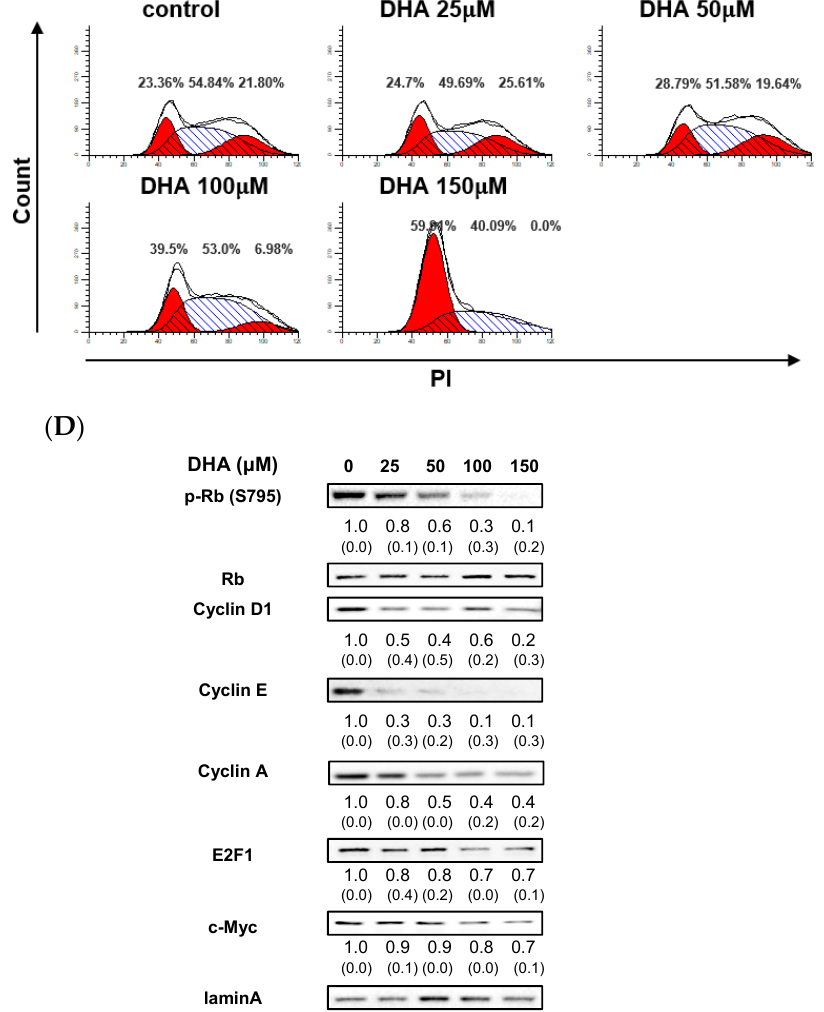
Figure 1. DHA inhibited the proliferation of human PDAC HPAF-II cells in association with down- regulation of cyclin D1 and c-Myc proteins. ( A ) Human PDAC HPAF-II, CFPAC-1 and MIA PaCa-2 cells were cultured in DMEM with different concentrations of glucose (5.5 and 25 mM) for various time points (24, 48, 72, 96 and 120 h). Cell survival was analyzed using MTT assay as described in Materials and Methods Section. Proliferation index, in comparison with the control subgroup (at a concentration of 5.5 mM glucose), is expressed as the mean ± SD (standard deviation) of three independent experiments. An asterisk (*) represent statistically significant differences in comparison with the control subgroup at the same time point ( p < 0.05). ( B ) Human PDAC HPAF-II, CFPAC-1 and MIA PaCa-2 cells were treated with DHA in DMEM containing 25 mM glucose for 24 h, respectively. At the end of experiment, cell survival was analyzed using MTT assay as described previously. An asterisk (*) represent statistically significant differences in comparison with the control subgroup at the same time point ( p < 0.05). ( C ) Human PDAC HPAF-II cells were treated with DHA in DMEM containing 25 mM glucose for 24 h. Measurement of the cell population at different cell cycle phases was performed using flow cytometry analysis, as described in Materials and Methods Section. ( D ) Western blotting analysis of nuclear proteins (at 24 h time point) was performed using antibodies against p-Rb (S795), Rb (internal control for p-Rb), cyclin D1, cyclin E, cyclin A, E2F1, c-Myc and lamin A. Lamin A was used as the internal control for cyclin D1, cyclin E, cyclin A, E2F1, c-Myc. Band intensities represent as the mean ± SD (within parenthesis) for the amount of each nuclear protein in comparison with corresponding control